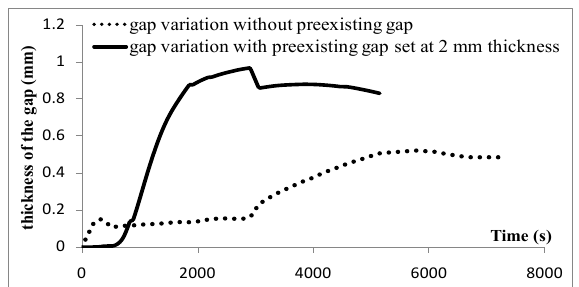
Figure 12. Evolution of the gap in the steel-concrete interface, considering an initial